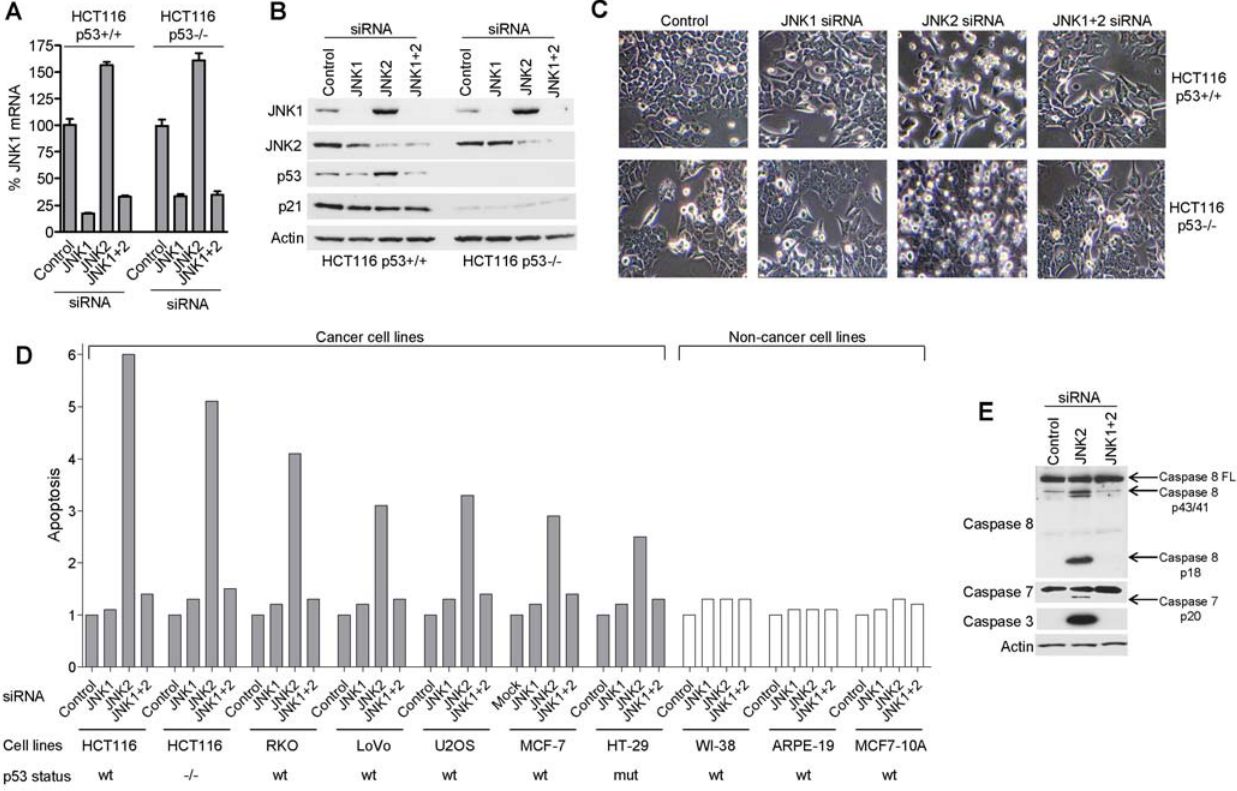
Figure 1. JNK2 constitutively suppresses JNK1-mediated apoptosis in a range of human cancer cell lines but not in non-cancer cells. (A) JNK1 mRNA levels, and (B) JNK1, JNK2, and also p53 and p21 protein levels determined 48 h after transfection with JNK1- and JNK2-siRNAs as indicated (Methods). (C) Phase contrast images of HCT116 cells 48 h after transfection with JNK1- and JNK2-siRNAs. (D) Apoptosis determined by annexin V labelling of siRNA-treated cells relative to untreated controls in a range of human cell lines (Methods. Note: apoptosis results are representative of at least three repeat experiments unless error bars are included for repeat analyses of a single experiment). (E) Caspase 8 and its cleavage products, activated caspase 7 and effector caspase 3 following RNAi-mediated silencing of JNK1 and JNK2 as indicated. Actin = loading controls. HCT116 p53 + / + and HCT116 p53 2 / 2 are isogenic clones of human HCT116 colorectal cancer cells (Methods).